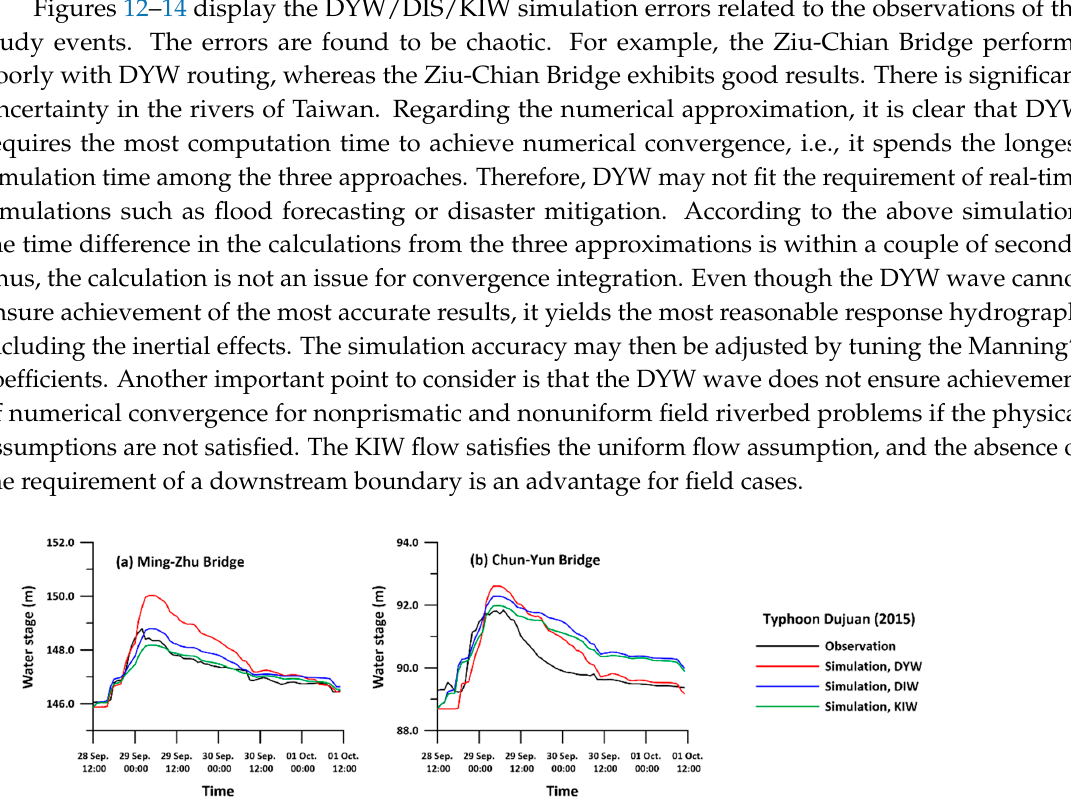
Figure 10. DYW/DIW/KIW simulations of Typhoon Meranti (2016).